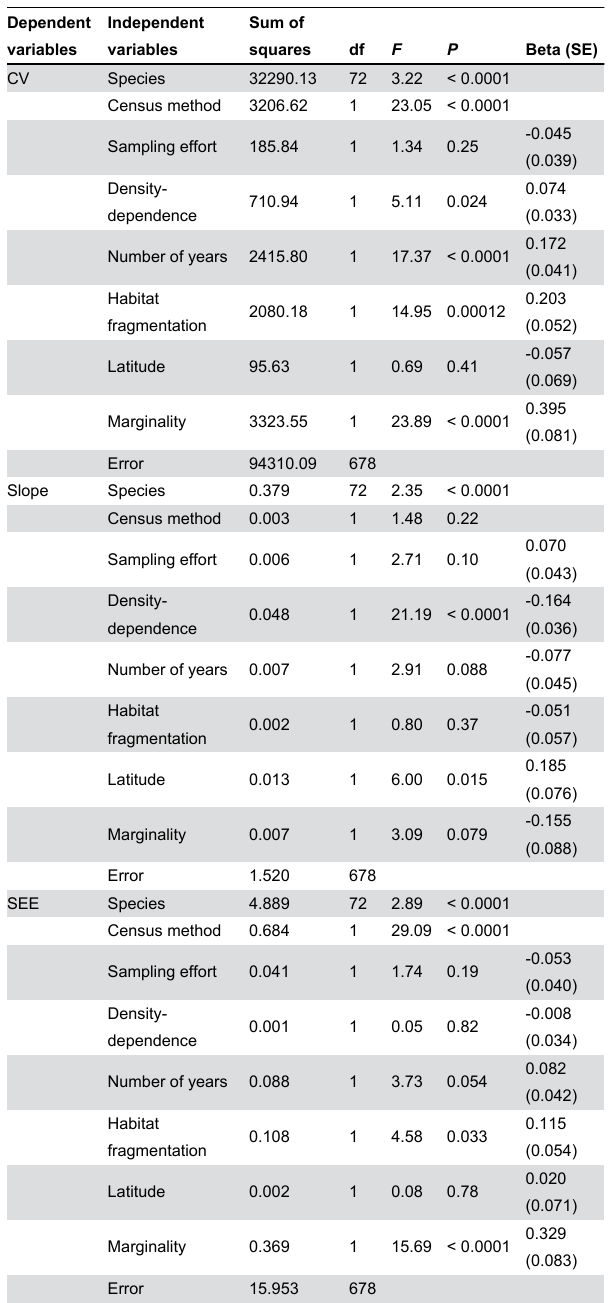
Table 2. General Linear Mixed Models with among-year variability in population size (CV of population indices corrected for sample size, see text), and slope and standard error of the estimate (SEE) after regressing population indices on year as dependent